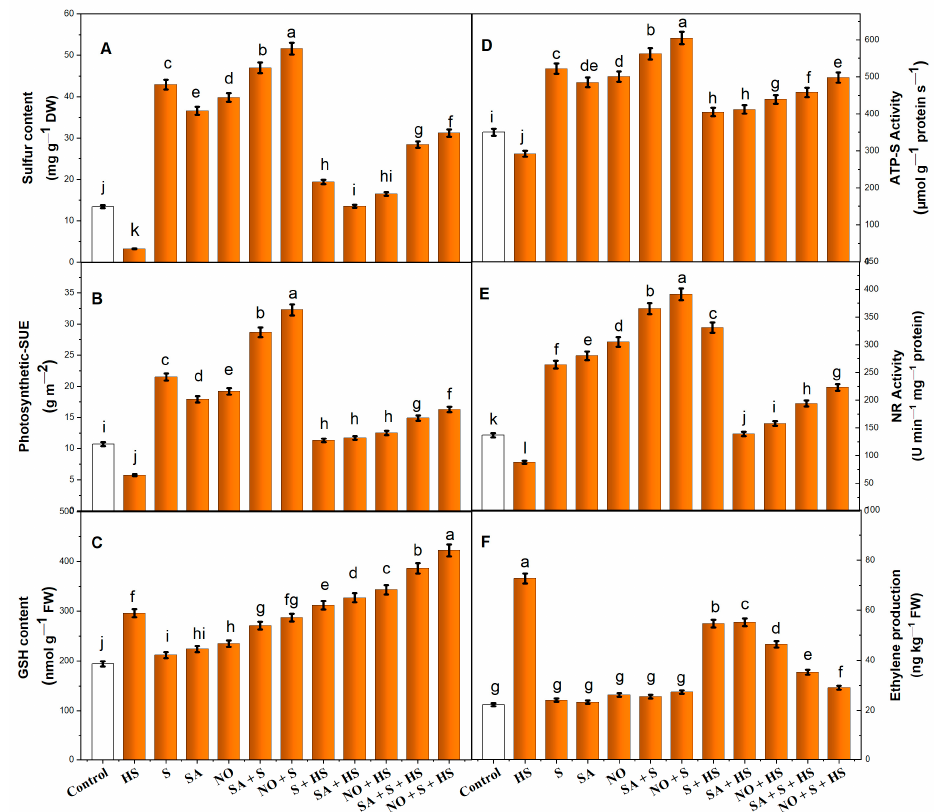
Figure 3. Sulfur content ( A ), photosynthetic sulfur use efficiency (p-SUE) ( B ), reduced glutathione (GSH) content ( C ), ATP-sulfurylase (ATP-S) activity ( D ), nitrate reductase (NR) activity ( E ) and ethylene production ( F ) in wheat ( Triticum aestivum L.) cv. HD-3226 treated with 0.5 mM salicylic acid (SA) and/or 50.0 µ M nitric oxide (NO)/2.0 mM SO 4 − 2 (S) individually or in combination in presence or absence of heat stress (HS; 40 ◦ C for 6 h daily for 15 days) at 30 days after germination. Data are presented as treatment mean ( n = 4). Data followed by the same letter are not significantly different by the LSD test at p ≤ 0.05. DW, dry weight; FW, fresh weight.